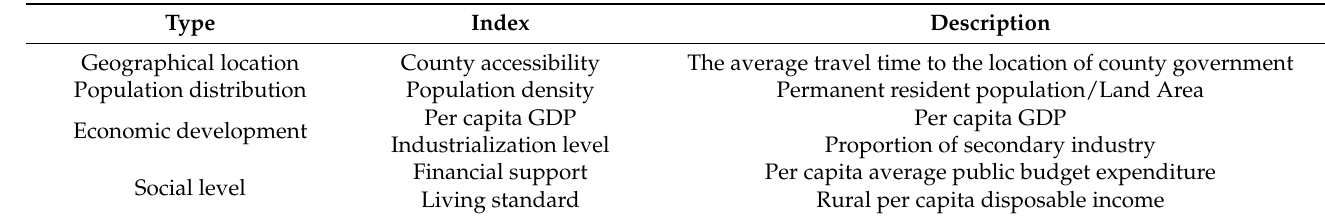
Table 5. Index system of accessibility of educational facilities in the YGGRD.